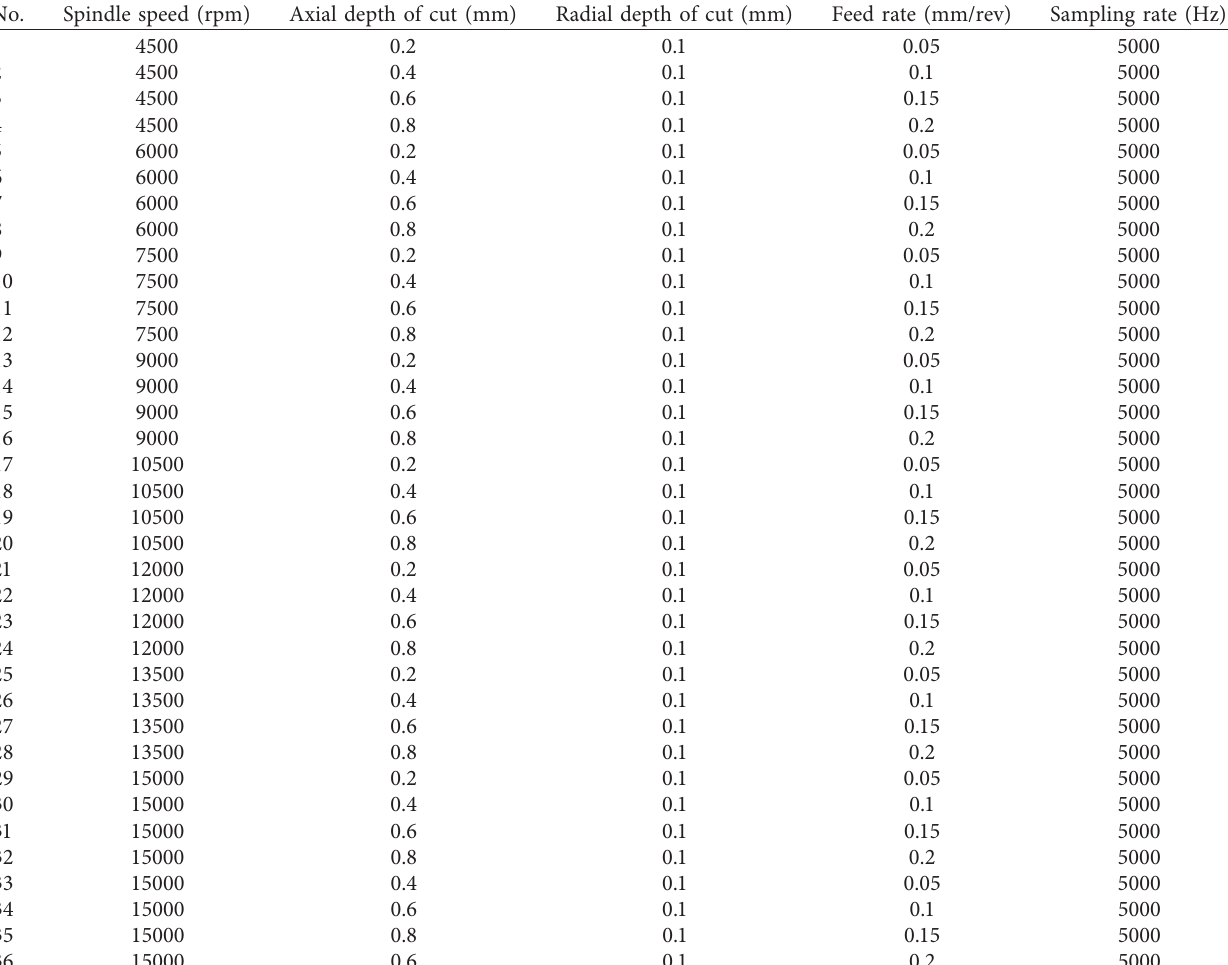
Table 2: Cutting parameters of 300M steel in end